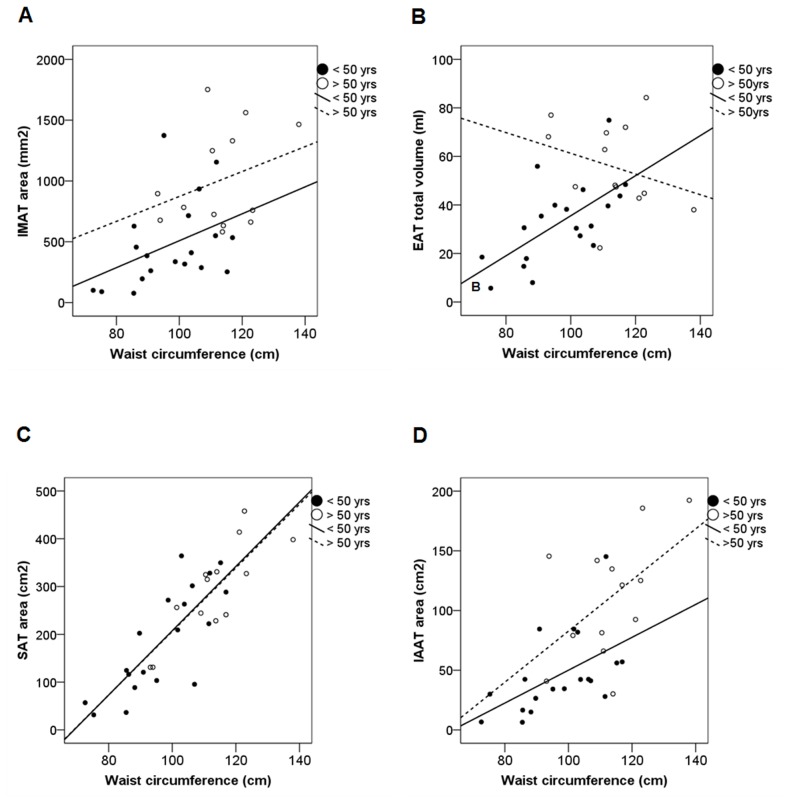
Correlations of adipose tissue depots with waist circumference according to age.Correlations of IMAT area (A), EAT total volume (B), SAT (C) and IAAT (D) areas with waist circumference. Solid lines represent correlations in younger subjects (≤50 years): IMAT: β = 0.46, p = 0.03; EAT: β = 0.63, p = 0.005; SAT: β = 0.81, p = 0.0001; IAAT: β = 0.51, p = 0.02 (gender-adjusted correlation coefficients). Dashed lines represent correlations in older subjects (>50 years): IMAT: β = 0.14, p = ns; EAT: β = −0.13, p = ns; IAAT: β = 0.54, p = 0.09; SAT: β = 0.76, p = 0.002.